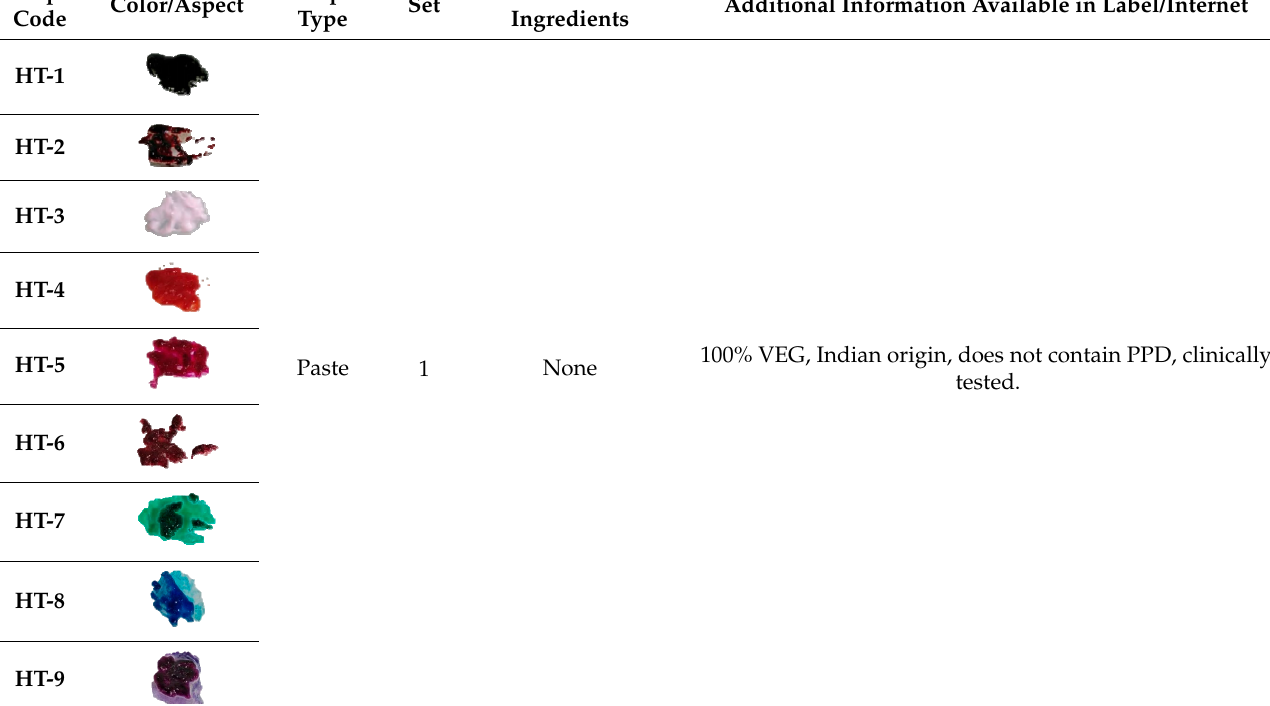
Table 1. Characteristics of the analyzed samples. HT: Henna Tattoo; HD: Henna Dye, HTD: Henna Tattoo-Dye; JT: Jagua tattoo; HPT: Herbaceous Plant Tattoo. HT-1